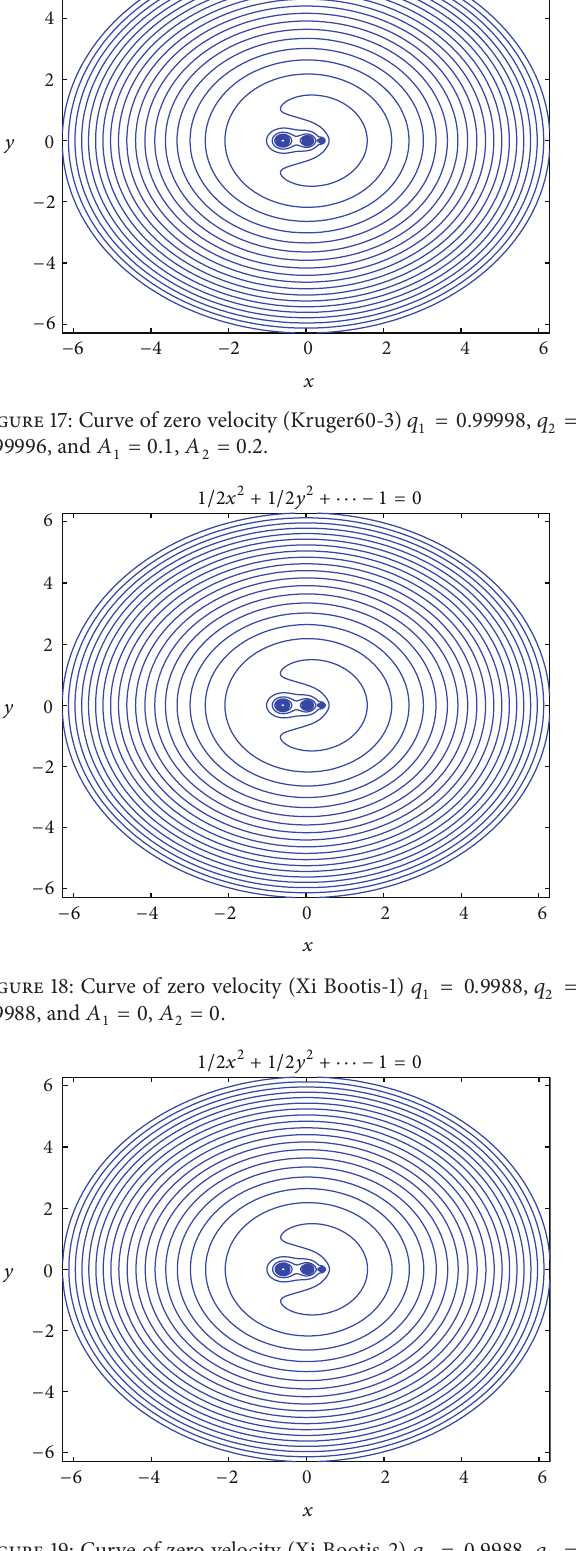
Figure 19: Curve of zero velocity (Xi Bootis-2) 𝑞 1 = 0.9988 , 𝑞 2 = = 0.01 , 𝐴 = 0.02 . 0.9988 , and 𝐴 1 2